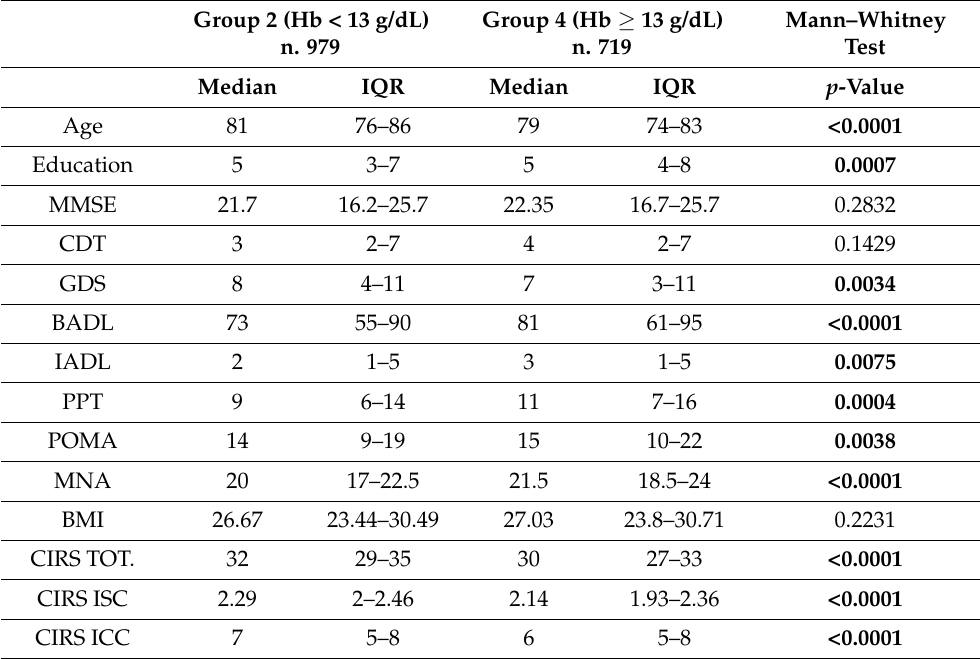
Table 7. Anemic group vs. non-anemic group (cut-off: Hb < 13 g/dL).